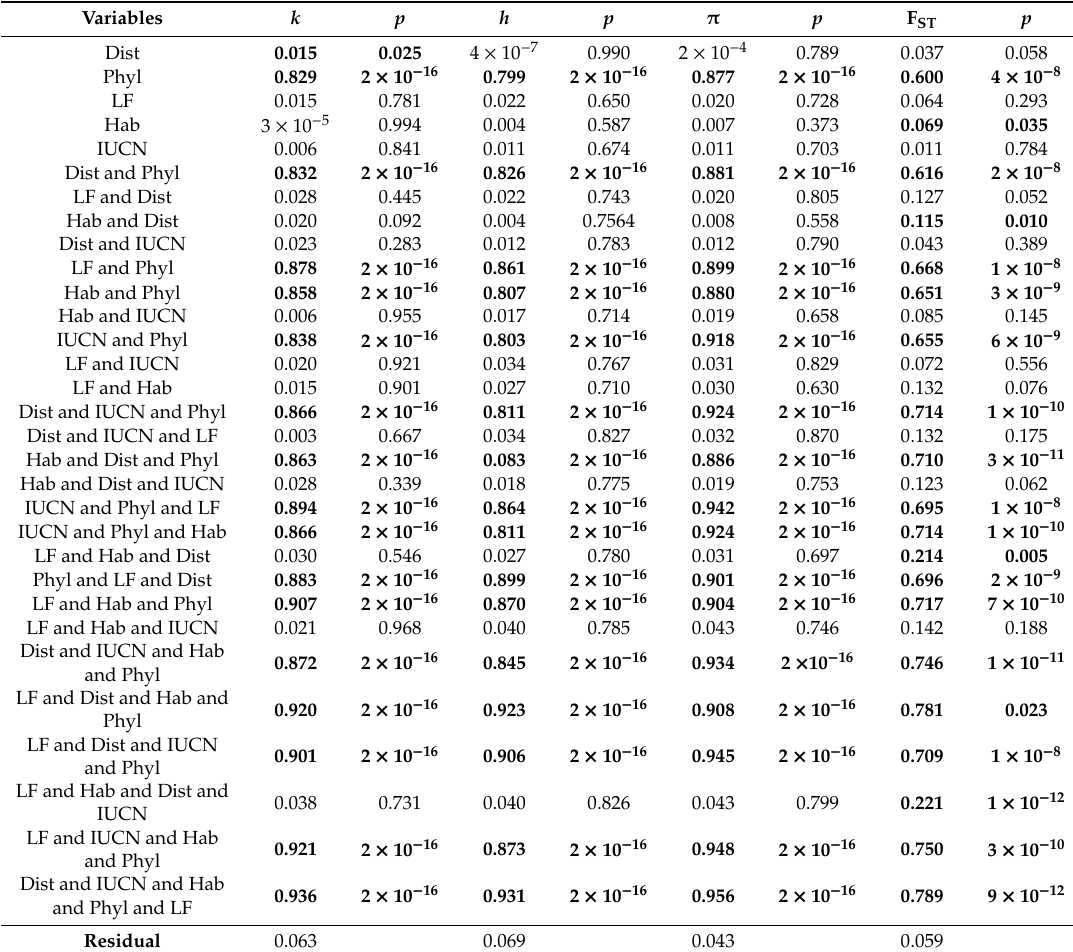
Table 1. Values of R 2 and p calculated for the influence of phylogeny and ecological variables, and the di ff erent combinations of these variables, on the genetic diversity ( k , h and π ) and F ST of plants. The data were obtained from studies that used cpDNA markers for the analysis of genetic